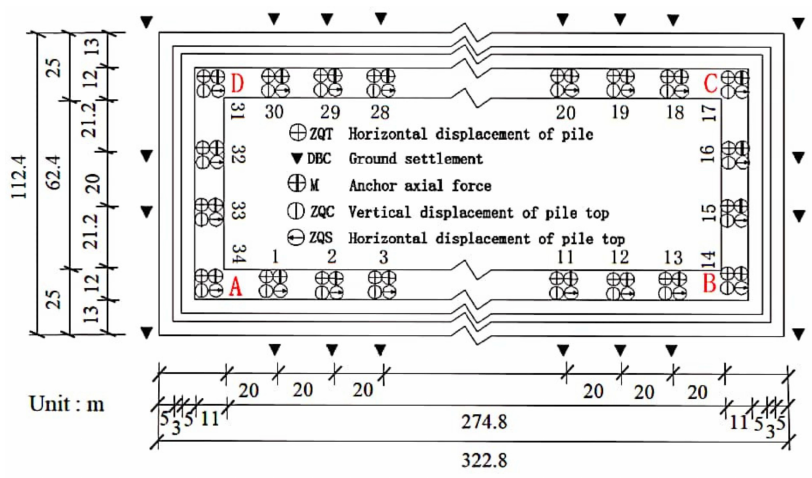
Figure 3. Schematic drawing of monitoring point